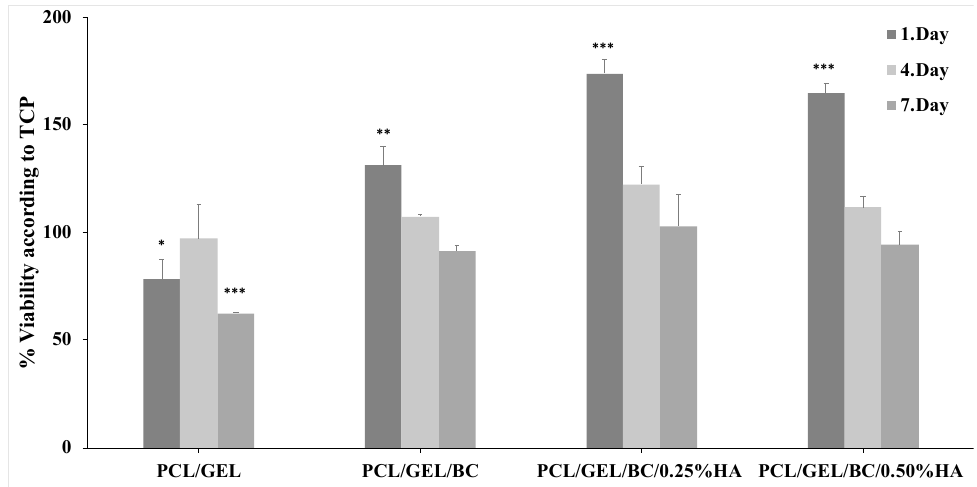
Figure 5. Cell viability analysis of PCL/GEL, PCL/GEL/BC, PCL/GEL/BC/0.25%HA, and PCL/GEL/BC/0.50%HA scaffolds. Data are the means ± S.E.; n = 3; * p ≤ 0.05, ** p ≤ 0.01, *** p ≤ 0.001 versus TCP, ANOVA, Tukey–Kramer multiple comparison test.